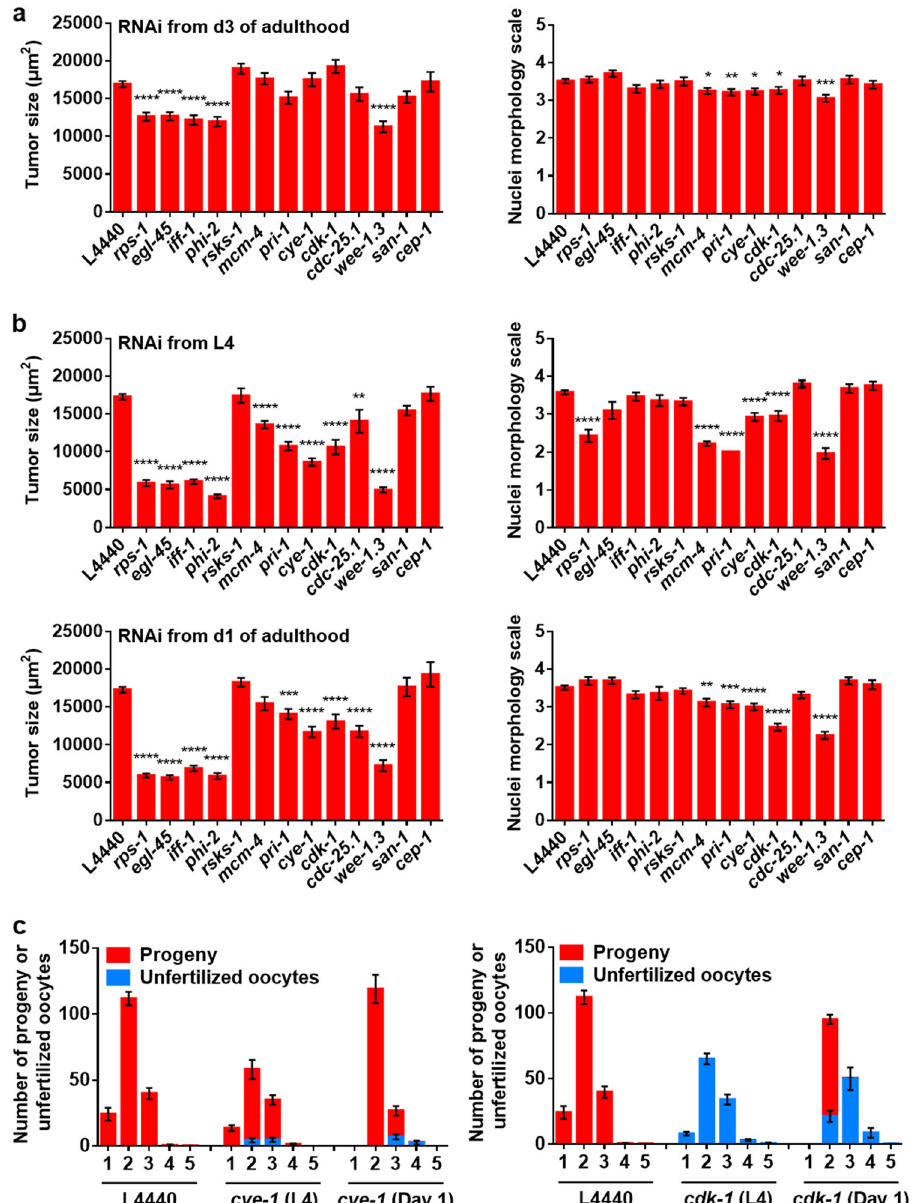
Fig. 4 Knockdown of genes required for early embryogenesis reduces tumor growth. a , b Effects of whole worm RNAi initiated at different ages on nuclear hypertrophy and tumor size (mean ± s.e.m.), measured on day 8 of adulthood. Dunnett multiple comparison test, Wilcoxon – Mann Whitney test, * p < 0.05; ** p < 0.01; *** p < 0.001; **** p < 0.0001. All trials, n ≥ 17. a RNAi initiated from day 3. b RNAi initiated from L4 and day 1. c Effects of cye-1 and cdk-1 RNAi on fertility schedule (progeny and unfertilized oocytes). All trials, n ≥ 9. Data are mean ±